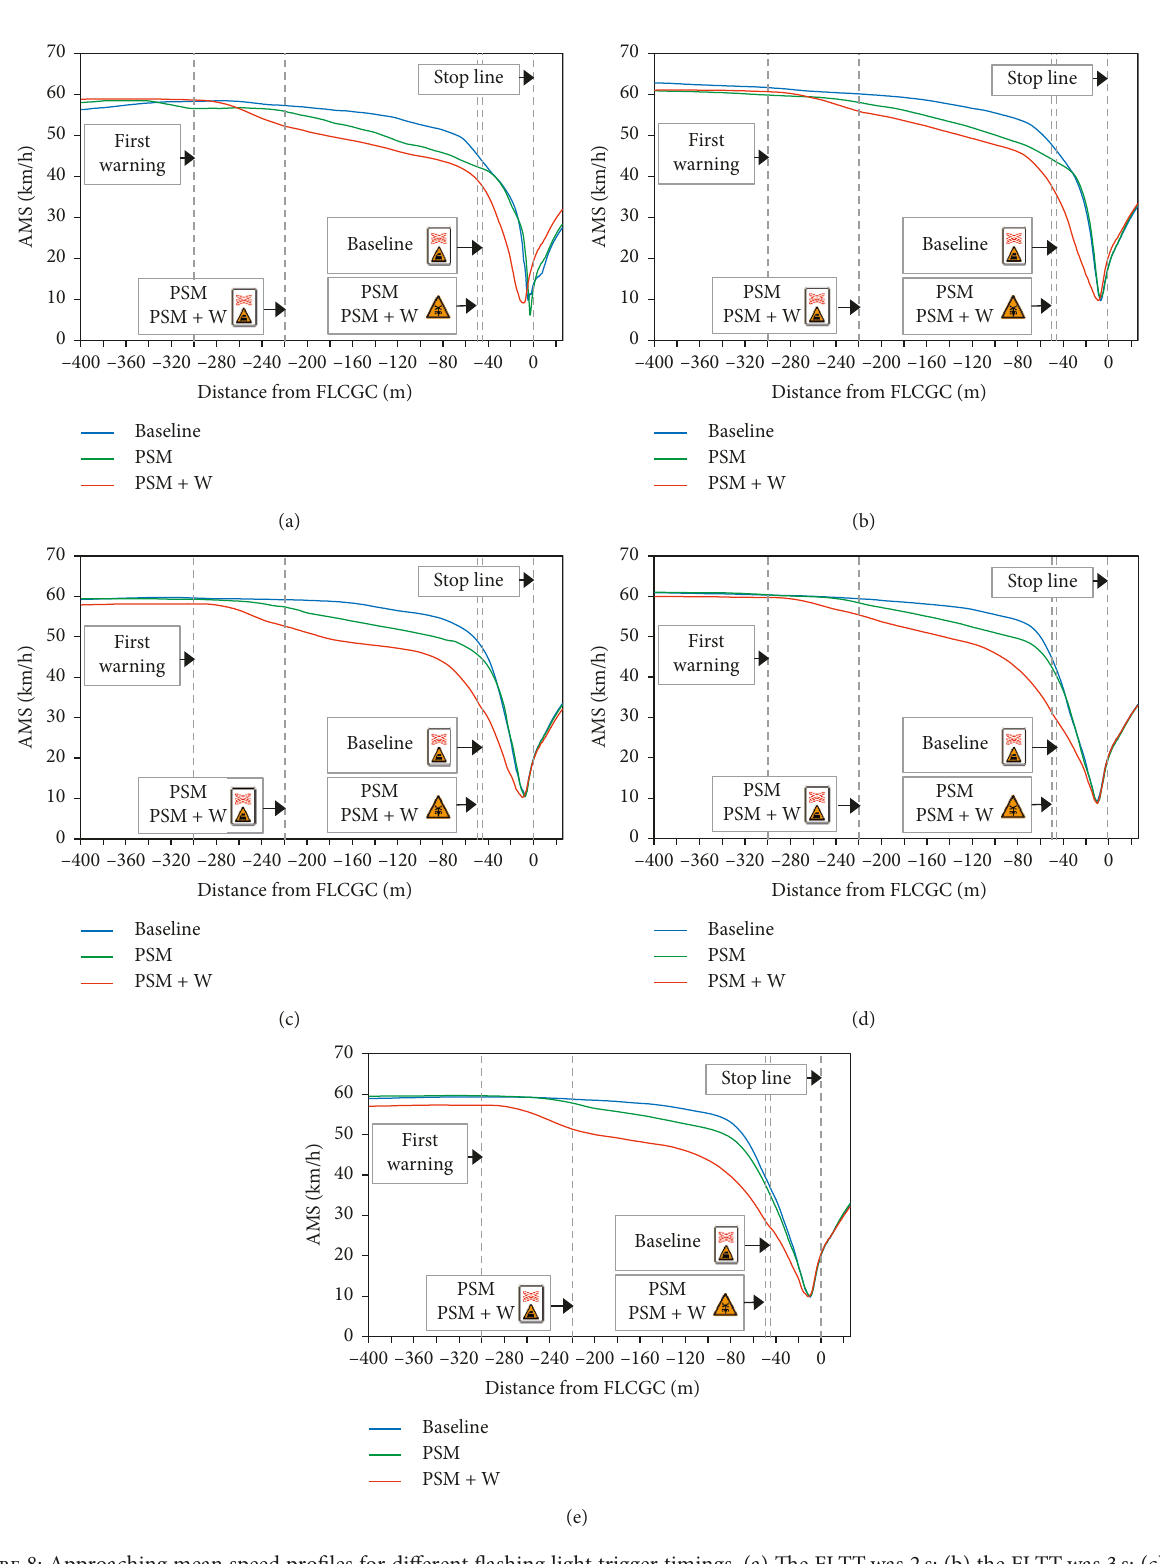
Figure 8: Approaching mean speed profiles for different flashing light trigger timings. (a) The FLTT was 2 s; (b) the FLTT was 3s; (c) the FLTT was 4s; (d) the FLTT was 5s; (e) the FLTT was